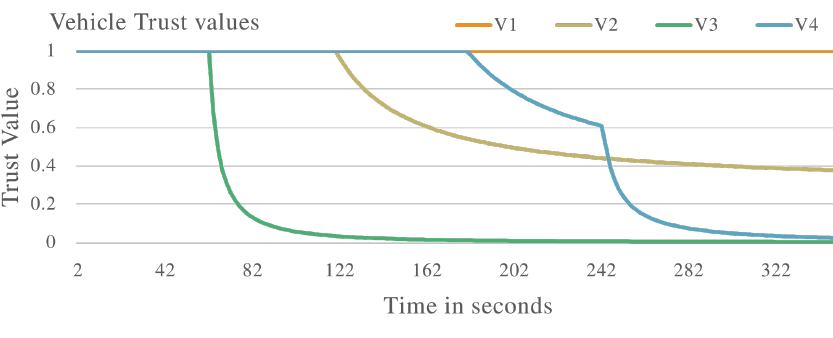
Figure 10. Vehicles trust values multiple malicious vehicles in the VANET that are either delaying packets, dropping packets or both delaying and dropping